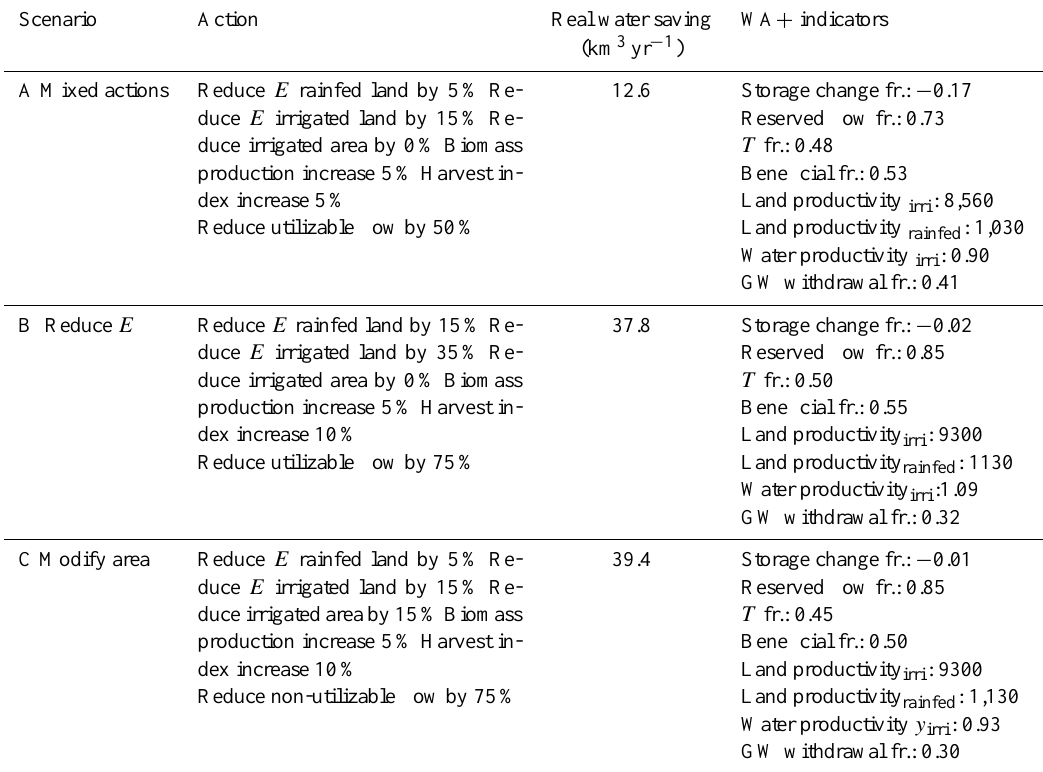
Table 4. Impact of alternative future scenario’s on WA + indicators aiming at zero-over-exploitation (storage change fraction) and increase food security (land